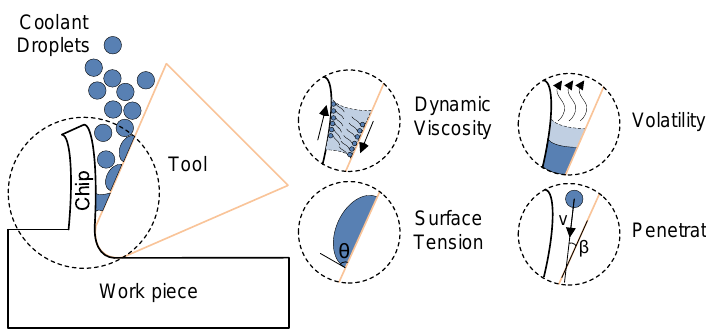
Figure 11. Schematic diagram of cooling and lubrication effect in a micromachining process.